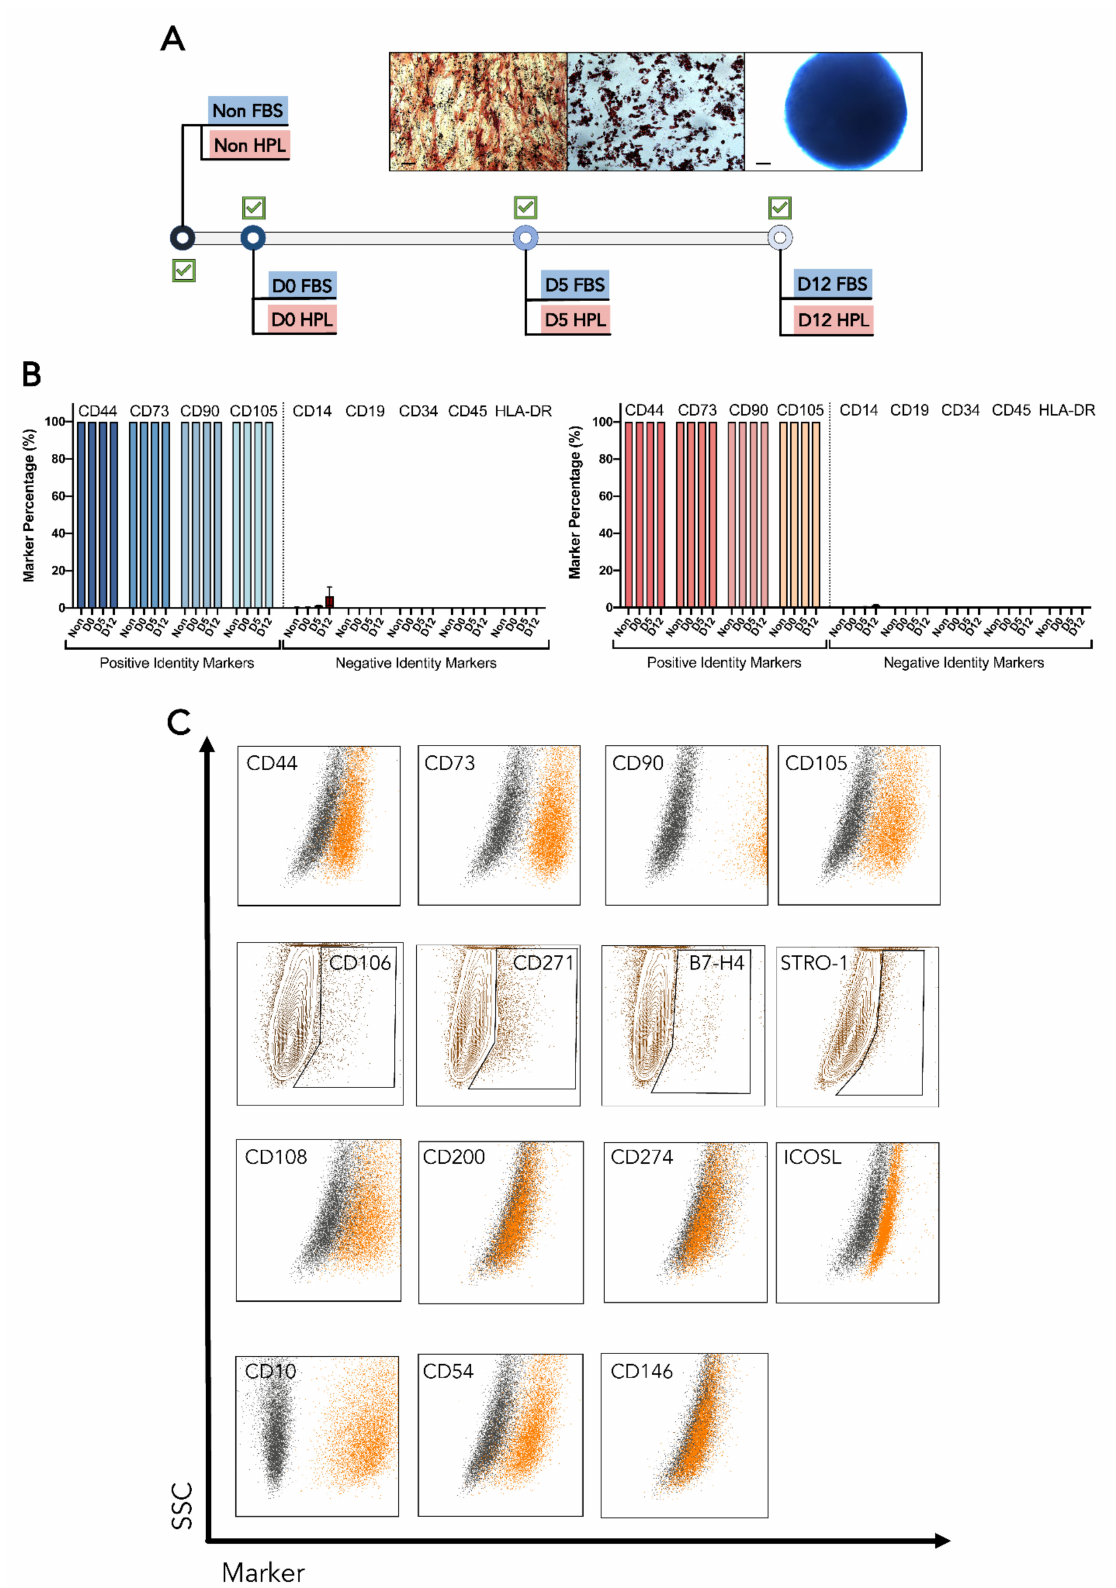
Figure 3. Differentiation potential and immunophenotype of MSC(AT) before and after encapsulation. ( A ) Map of MSC(AT) tri-lineage differentiations showing successful differentiation in every timepoint. The representative images include osteogenic ( left ), adipogenic ( center ), and chondrogenic ( right